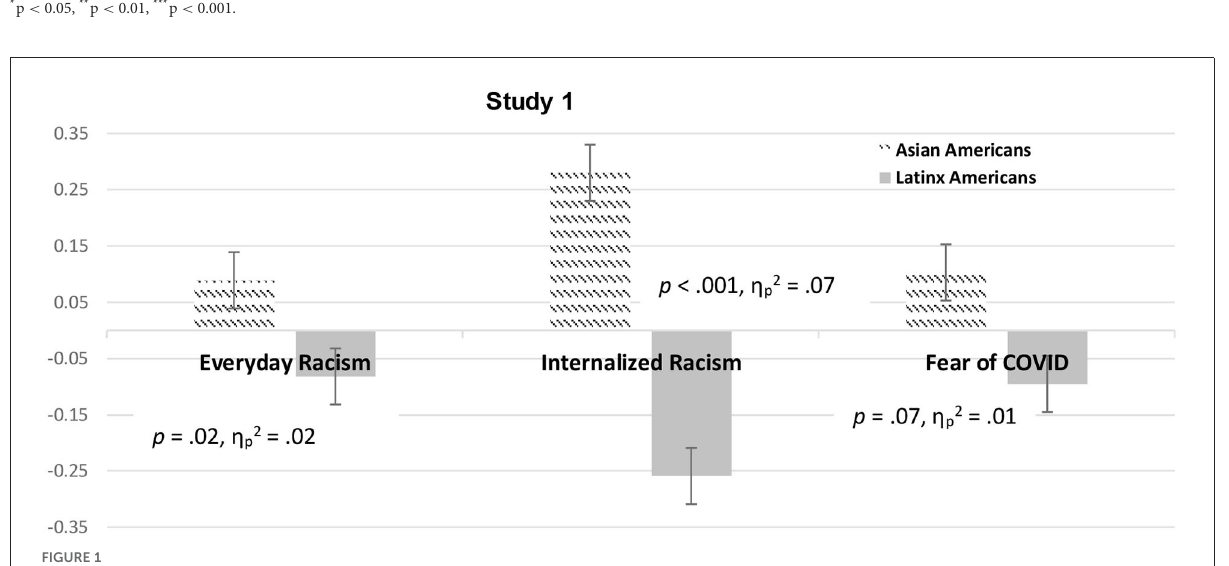
not internalized racism. Notably, more everyday racism